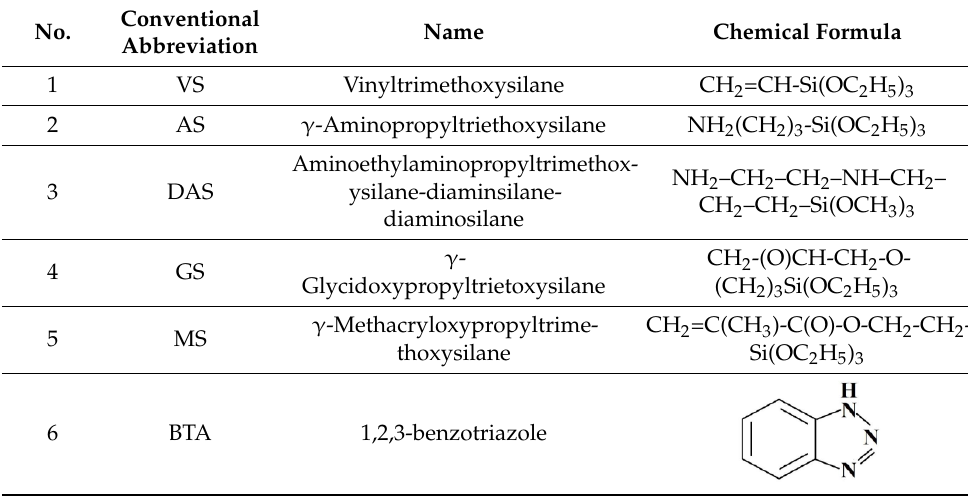
Table 2. Composition of solutions used to modify the surface of metal